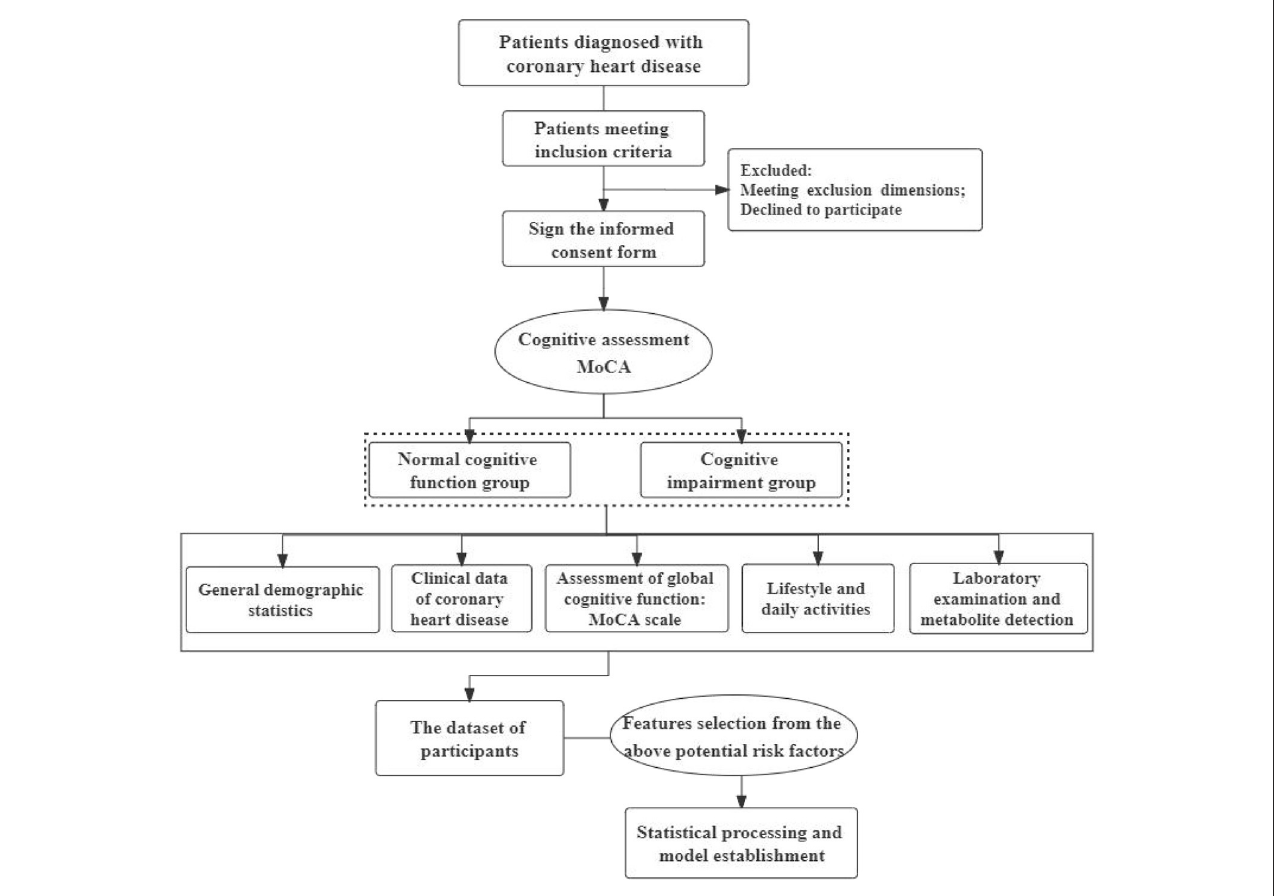
FIGURE1 Flow chart of specific